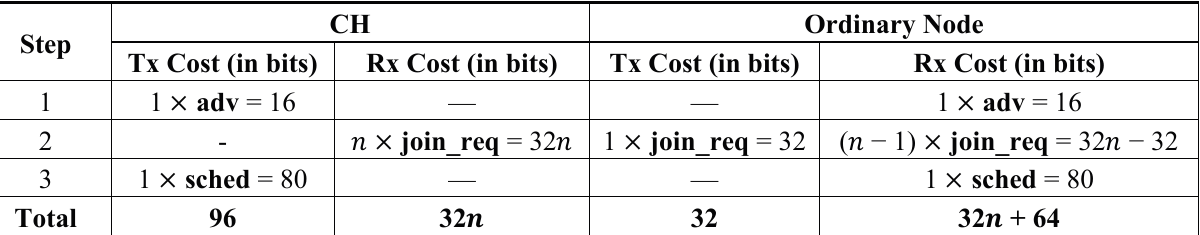
Table 8. Communication cost of LEACH in setup phase.